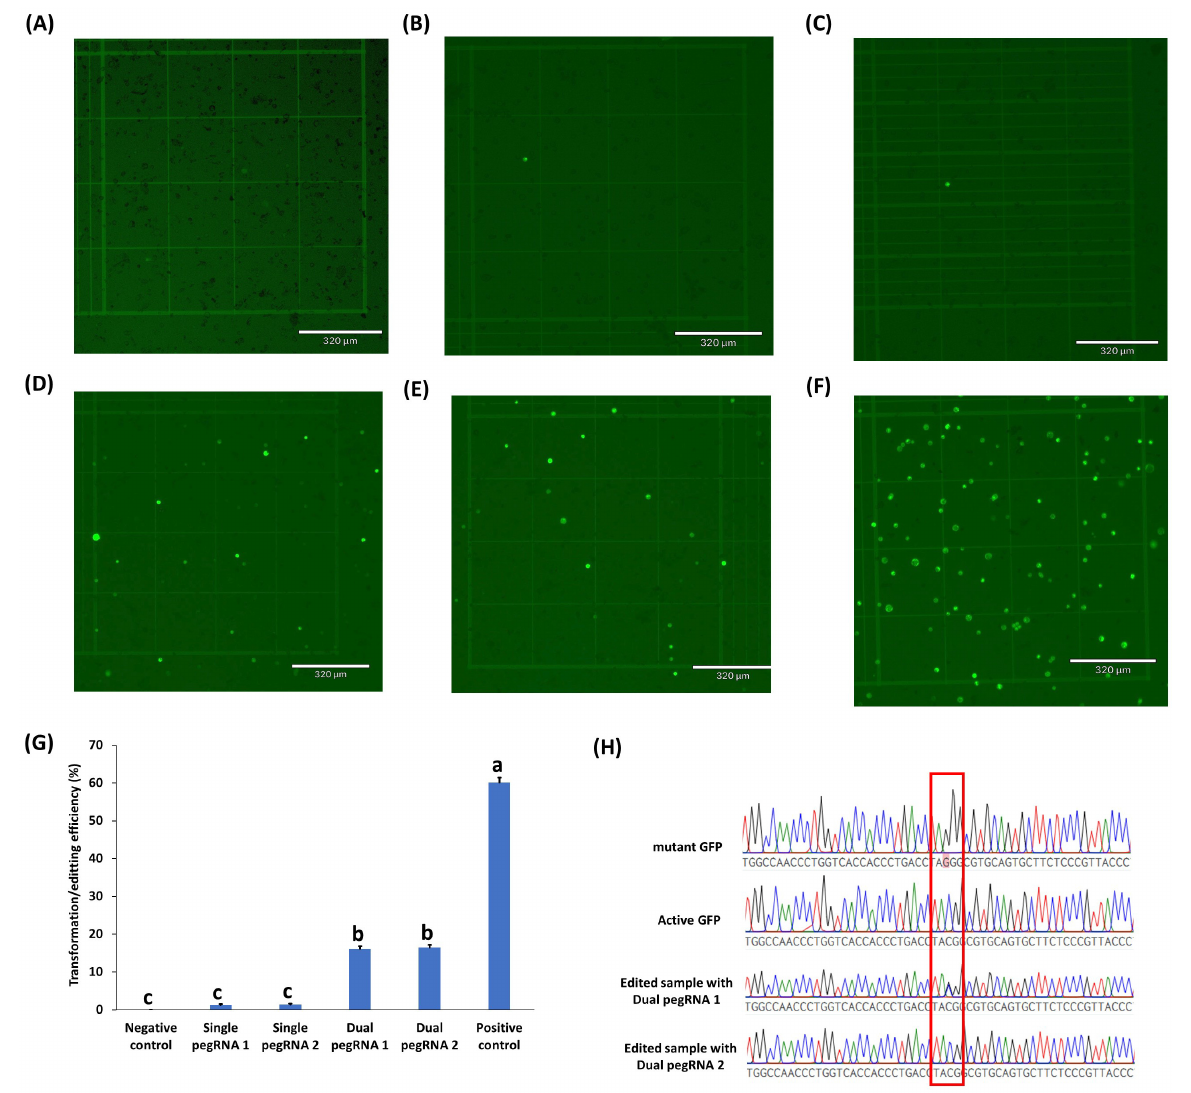
Figure 3. Prime editing in rice protoplasts transformed using single or dual pegRNAs containing vectors. ( A ) negative control (no GFP plasmid/prime editing vectors); ( B ) protoplasts with single pegRNA1 containing vector; ( C ) protoplasts with single pegRNA2 containing vector; ( D ) protoplasts with dual pegRNA1 containing vector; ( E ) Protoplasts with dual pegRNA2 containing vector; ( F ) positive control (protoplasts with CmYLCV_GFP vector); ( G ) the transformation efficiency (TE) of protoplasts transformed with different prime editing vectors. TE was evaluated after incubation in 40% PEG solution with 20 µg plasmid DNA of each prime editing vector. Values represent means ± SE (n = 6). The different letters indicate significant differences at p < 0.05; ( H ) Sanger sequencing results of active GFP, mutant GFP, and samples transformed by the dual pegRNAs containing vectors. Scale bar length for all pictures was 320 µm. Micrographs under the bright field are shown in Supplementary Figure S3.